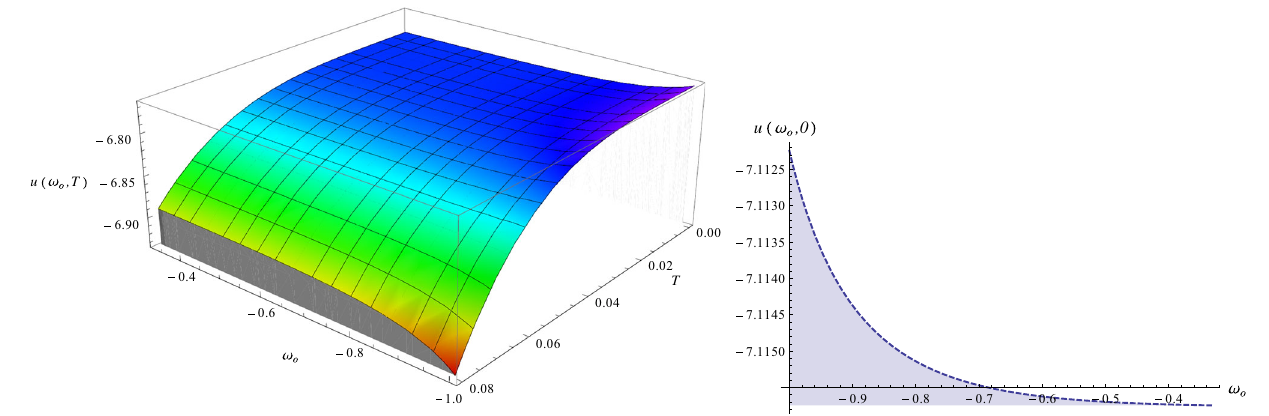
Fig. 1 u 0 ( m g , T ) and u 0 ( m g , 0 ) depicted at the equator (multiplied by 10 3 ) for a set of parameters: r = 10, (cid:13) = 2 ω d , θ = π/ 2, α o = 0 . 001, (cid:3) = − 1 / 3, (cid:3) = − 2 / 3, α = γ m 2 γ = 10 − 3 , L = k = 1 o p B 2 2 g ,